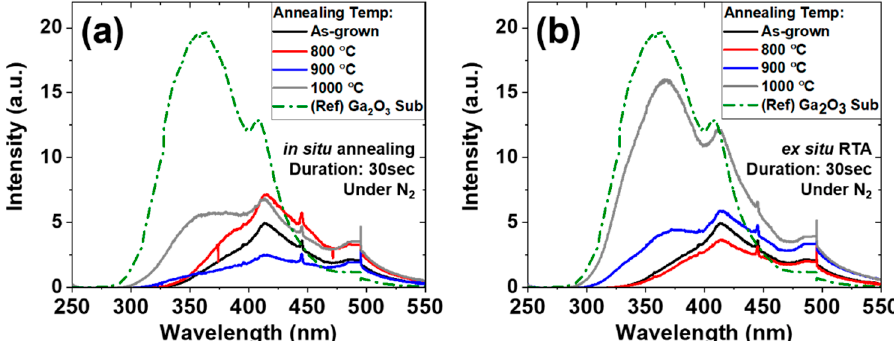
Figure 6. ( a ) PL spectra of the as grown sample and the samples in situ annealed at various temperatures; ( b ) PL spectra of the as grown sample and the samples annealed by ex situ RTA at various temperatures. The PL spectrum from (010) Ga 2 O 3 substrate is also plotted as a reference .